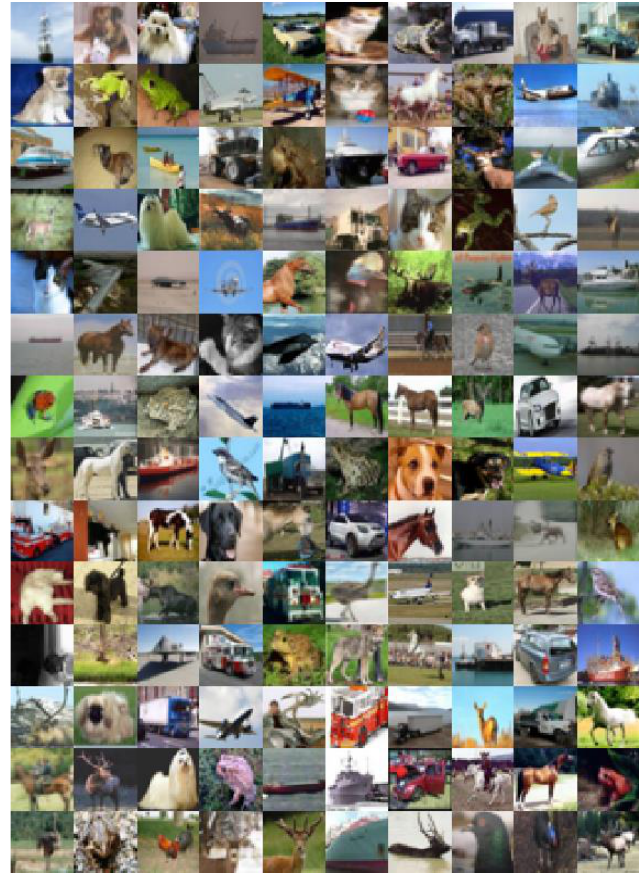
Fig. 1. Heterogeneity of colour images in a subset of the CIFAR-10 dataset [8].